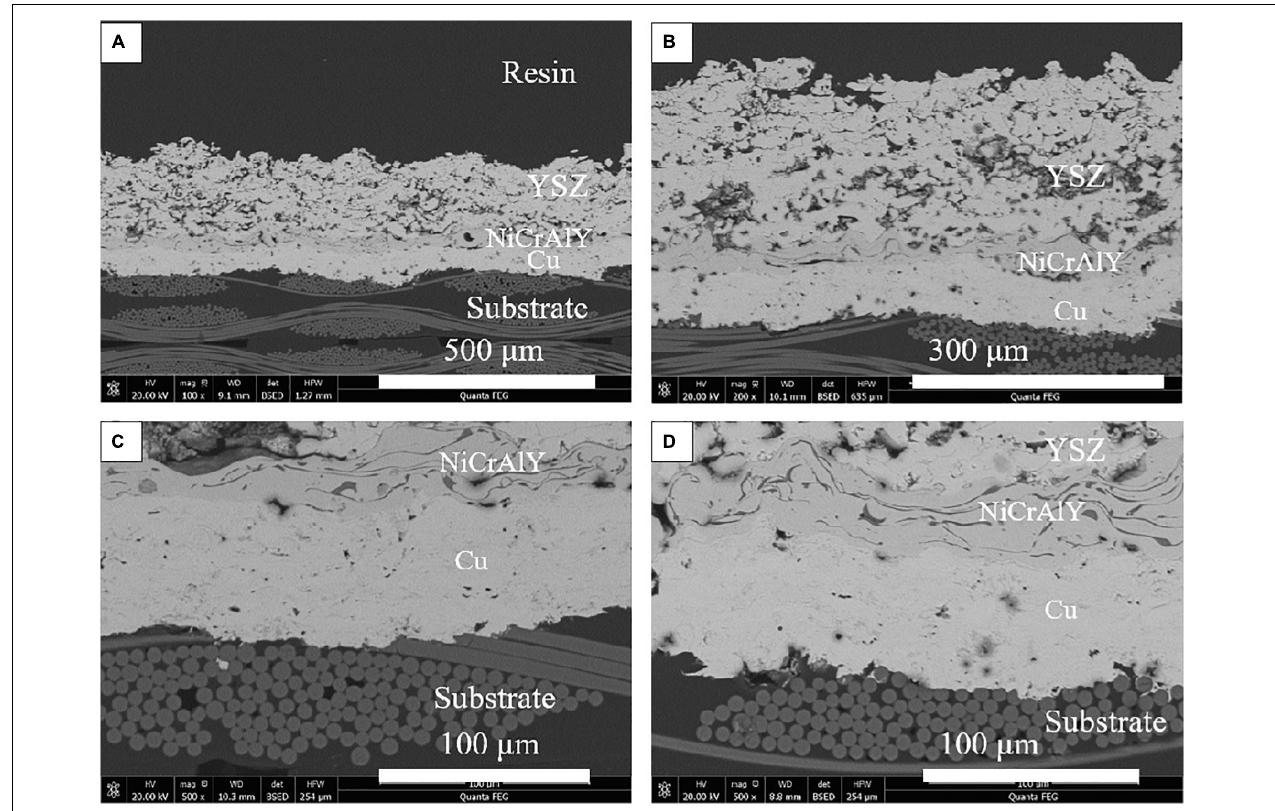
FIGURE 7 | The cross-sectional microstructures of coating C50N50Y200 after thermal ablation test: (A,B) ablation center region and (C,D) ablation rim region.